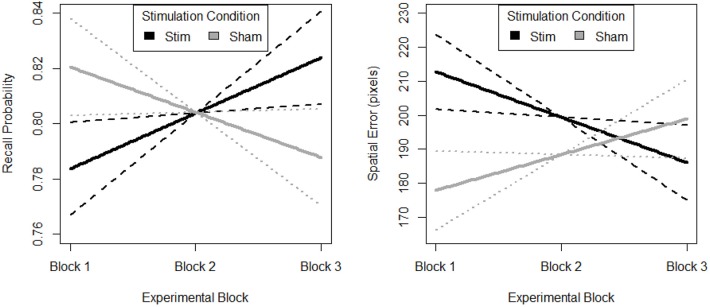
Behavioral performance (Left. probability, Right. error) on spatial memory task. Block 1, both groups receive sham, block 2, stim group received stimulation, sham group received sham, and block 3, both groups were monitored for 33 additional trials of the task. Solid lines depict fixed effects regression slopes, dashed lines represent 95% confidence bands of regression estimate.